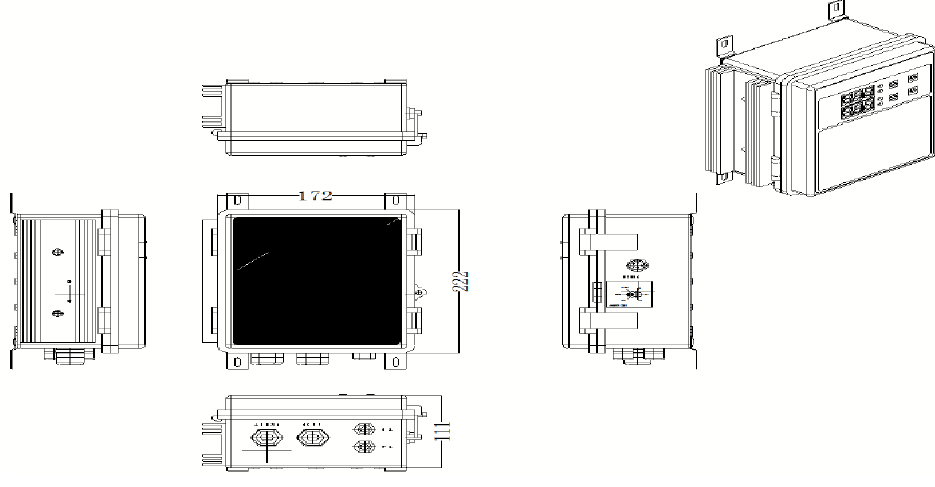
Figure 2. the composition of a ventilation